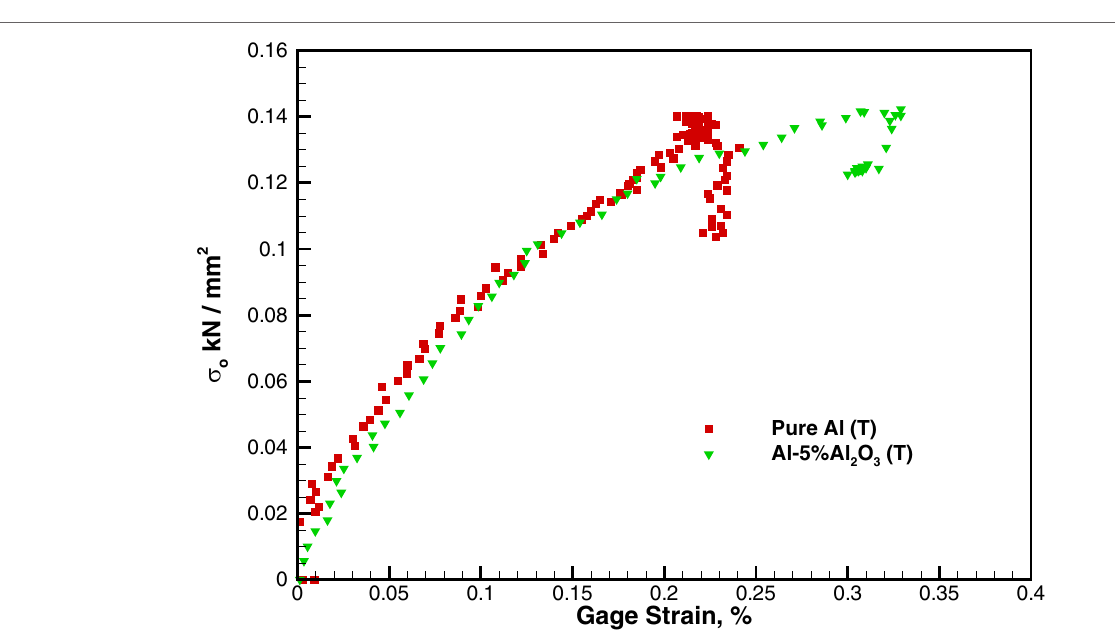
shows that the transverse strain for the pure aluminum sample is less than that of the Al–5%Al 2 O 3 sample. Note that in this figure, a gage length of ~5 mm is used to evaluate the